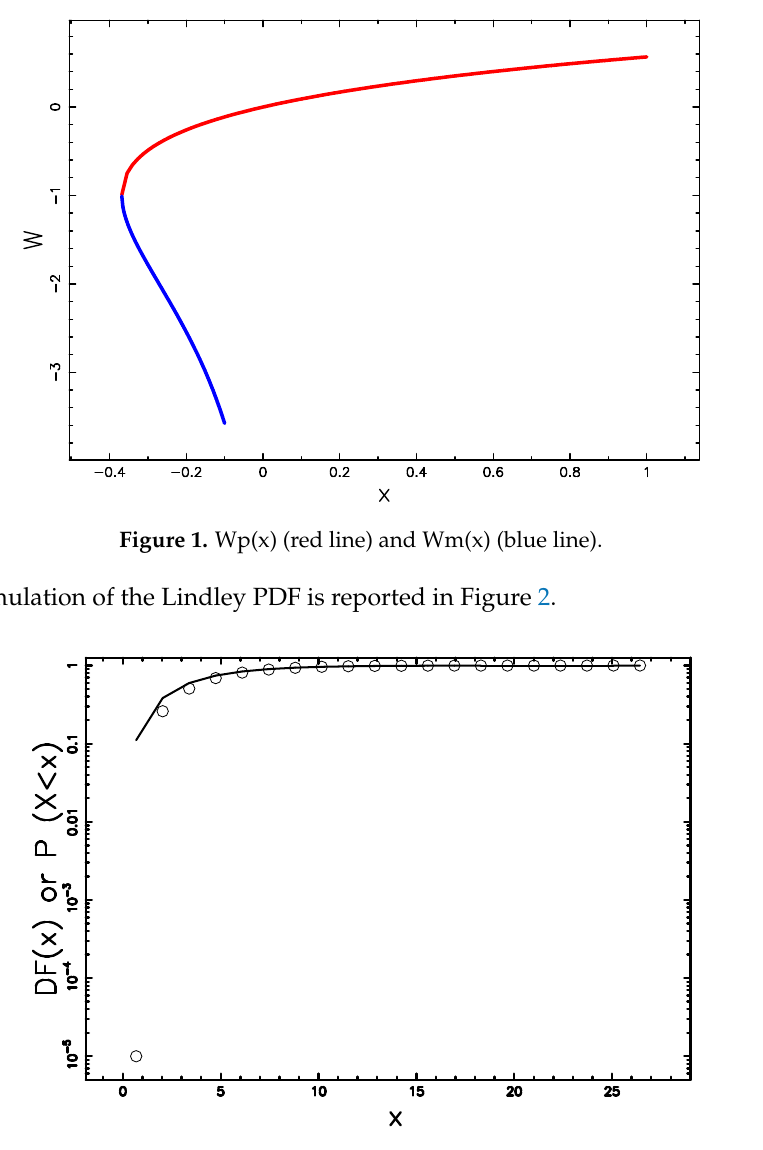
Figure 2. Histogram of the simulated Lindley PDF generated according to formula (5) and theoretical Lindley PDF (full line), 100,000 random points and c =